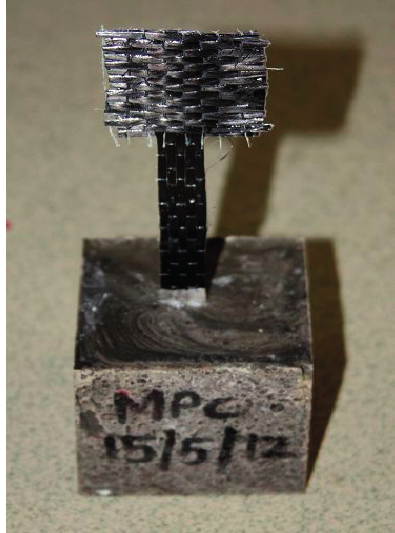
Figure 2. Pullout test